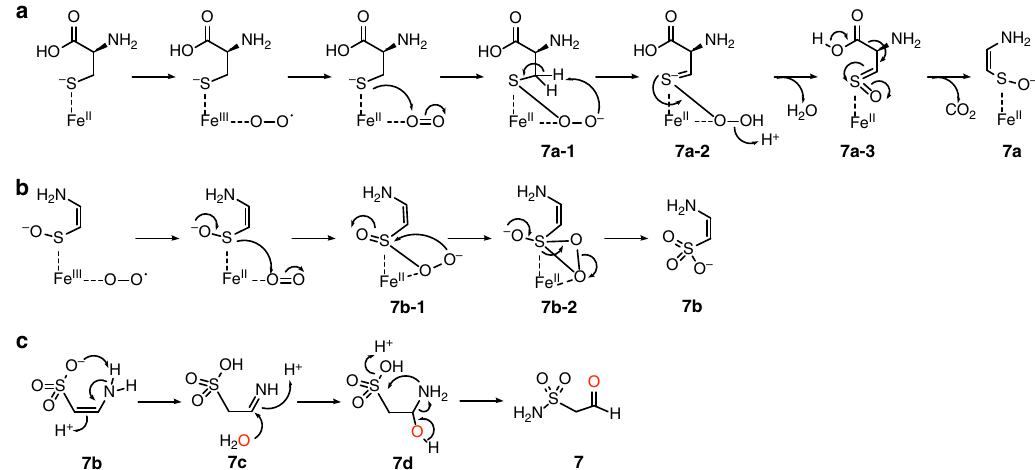
Fig. 5 The proposed reaction mechanism of SbzM. a L-cysteine is transformed into ( Z )-(2-aminovinyl)sulfanolate ( 7a ) via the decarboxylation coupled with sulfur monooxygenation. b 7a is dioxygenated into ( Z )-2-aminoethanone-1-sulfonate ( 7b ). 7b was tautomerized into 7c , the hydration of the imine of 7c , and the hydrolyzed amine in 7d attacks the protonated sulfonate to yield 7 with the release of water. The Fe can be substituted with Ni. The oxygens derived from water are colored